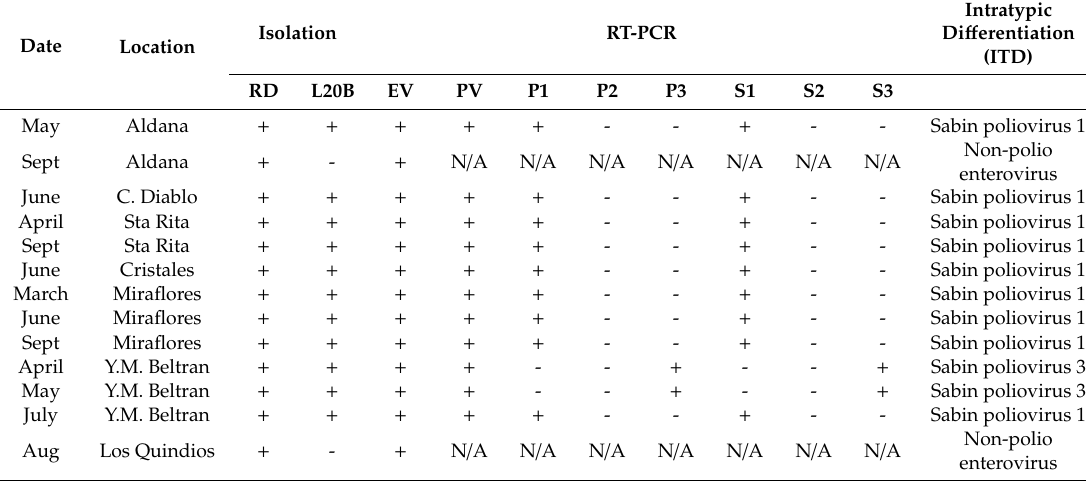
Table 3. Poliovirus and non-polio enterovirus isolated from wastewater samples in the municipality of Armenia, Colombia (March to September,